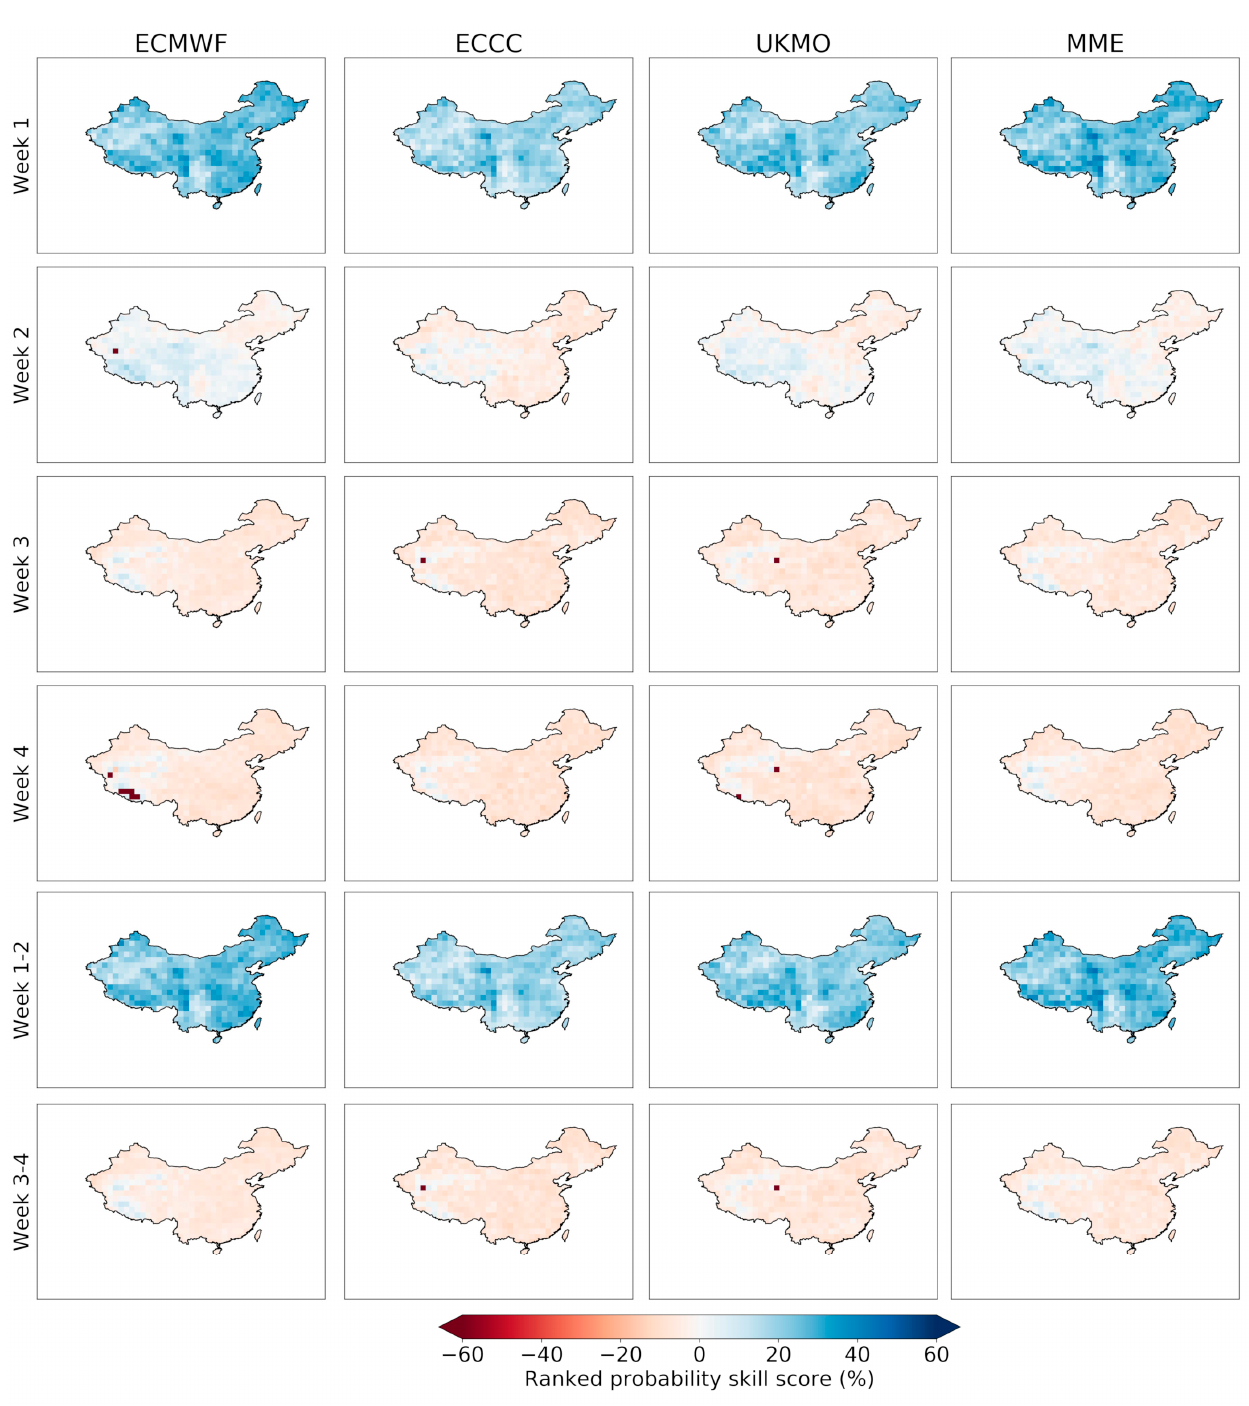
Figure 8. Ranked probability skill score of week 1, week 2, week 3, week 4, week 1–2, and week 3–4 forecasts of the ECMWF model, the ECCC model, the UKMO model, and the MME model over China during the boreal summer monsoon.